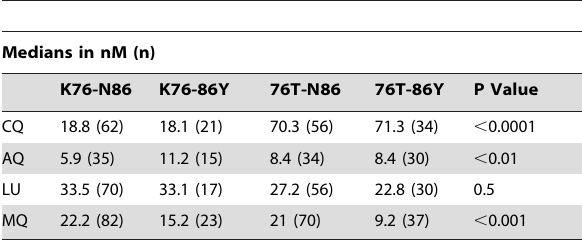
Table 3. Combined Pfcrt 76/Pfmdr1 86 haplotype